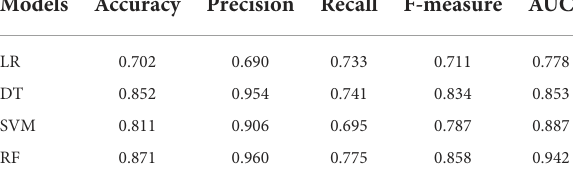
TABLE 5 Results of classification models in SMOTE-processed